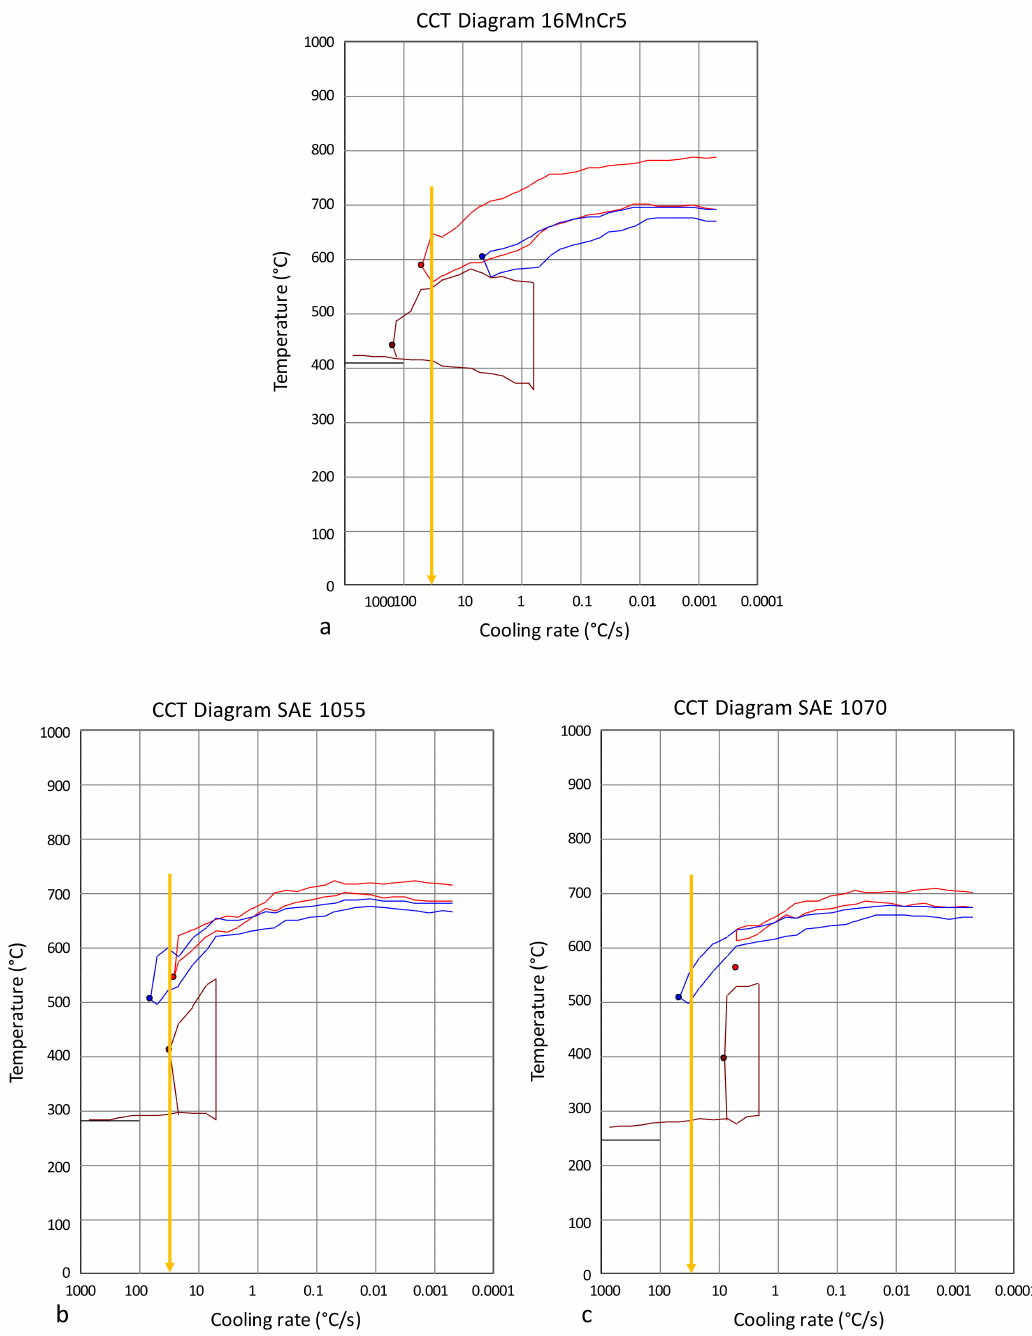
Figure 9. Neural network calculated CCT diagrams for: ( a ) 16MnCr5, ( b ) SAE 1055 and ( c ) SAE 1070 material types; the orange line is the measured cooling rate during laser welding in this study. The ferrite, pearlite, bainite and martensite phases form in the CCT diagram when the (yellow) cooling curve/line crosses the red, blue, brown and black curves and regions